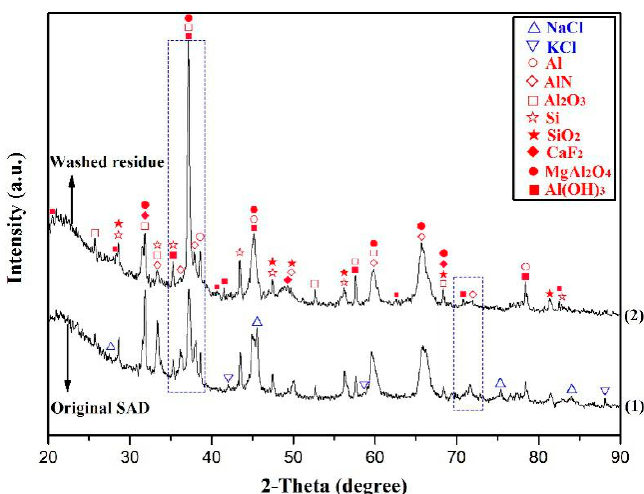
Figure 4. The XRD patterns of the SAD before and after water washing: (1) original SAD, (2) washed Figure4. TheXRDpatternsoftheSADbeforeandafterwaterwashing: residue.